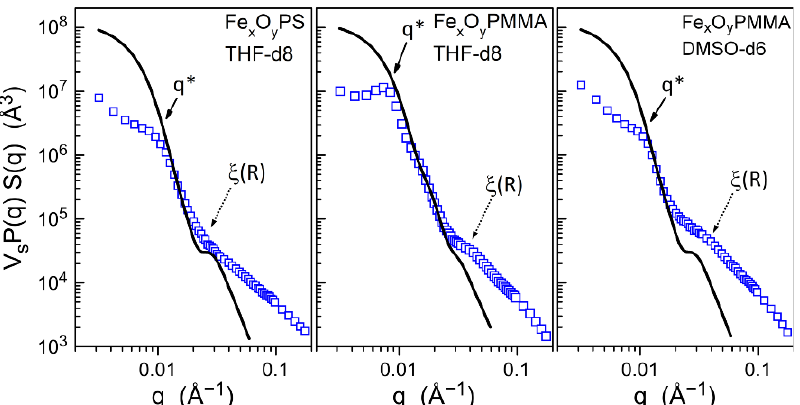
Figure 8. SANS curves determined as a function of scattering vector for PS/γ -Fe 2 O 3 in THF-d8 ( left ; ϕ v = 0.0058), PMMA/γ -Fe 2 O 3 in THF-d8 ( middle ; ϕ v = 0.0079), and PMMA/γ -Fe 2 O 3 in DMSO-d6 ( right ; ϕ v = 0.0047); the black lines are the theoretical scattering curve for isolated hybrid objects swollen with solvent; dotted arrows: predicted cross-over zone ξ (R) to predominant blob scattering of isolated objects; solid arrows: cross-over zone q* towards q -range of interacting objects.